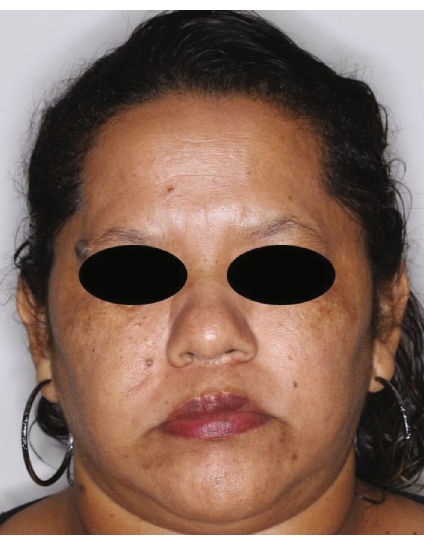
Figure 6: Two-year follow-up with no signs of